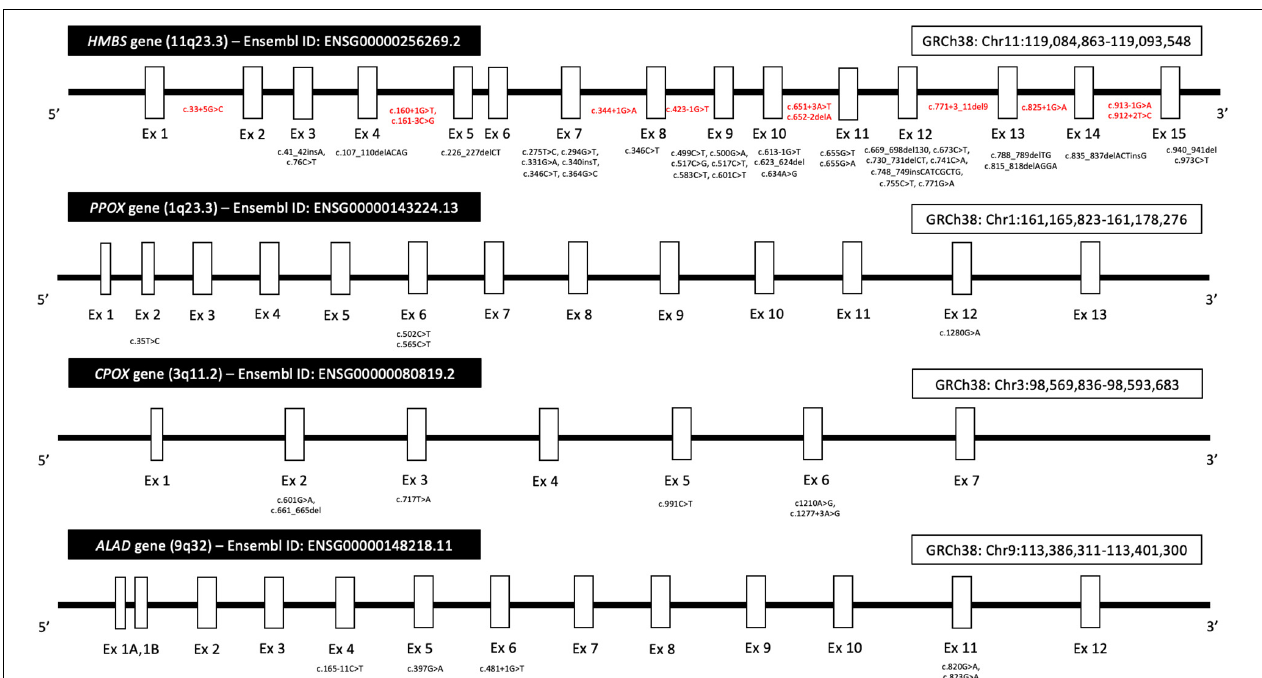
FIGURE 4 | Diagram showing the location of pathogenic and likely pathogenic variants in the four genes ( HMBS , PPOX , CPOX , and ALAD ) associated with AHP. Variants were included according to data from the Genome Aggregation Database (gnomAD, browser v2.1.1), the Ensembl Project browser, and the ClinVar database public archive (all last accessed on August 10, 2021). Most variants in exon regions (black color) are missense. Intronic variants are represented in red color. Legend: Ex, exon; GRCh, human Genome Reference